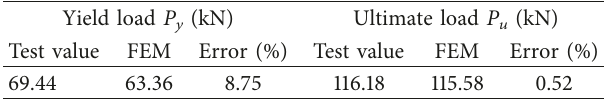
Table 2: Comparison of the calculation results.